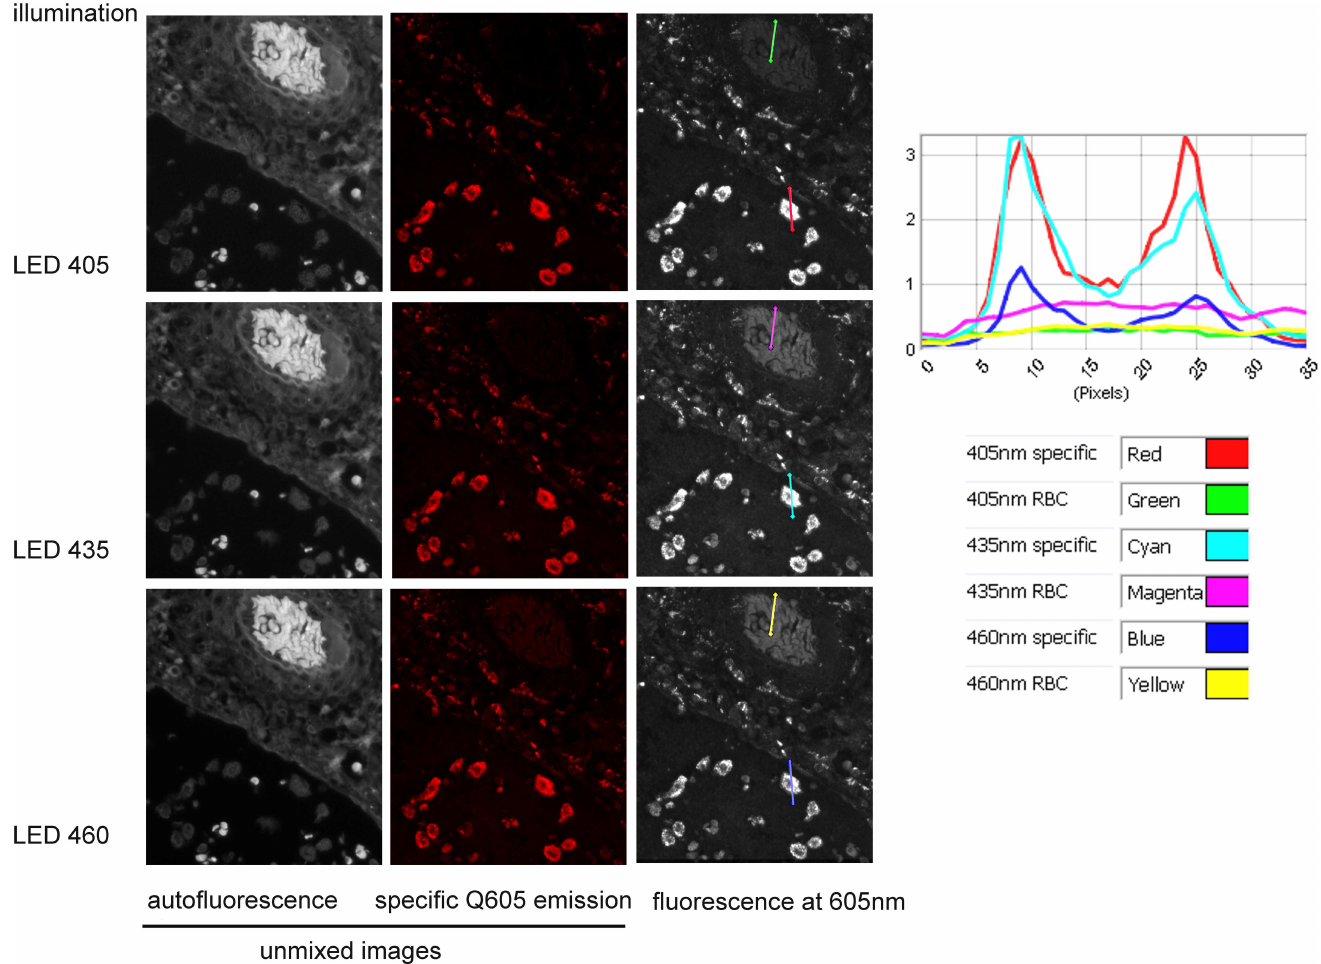
Fig 8. Comparison of specificand autofluorescence levels withLED illuminationat 405, 435 or 460nm. Left & middlepanels:intensityimages unmixed froma cube of imagestaken between500 and 720nm using a tunable filtercamera (NuanceFX),showing the autofluorescence and Qdot 605. Right panel & curves: Imageswere taken at 605 nm (peak of specific fluorescence) using the Nuance tunable camera.The same profilelines drawn on red blood cells (green,magenta& yellow lines) and on a macrophage positively labelled(red,cyan & blue) give the fluorescenceintensityprofileshown on the graph. Note that specific stainingis of similarlevel in picturestaken under405 and 435 nm (red& cyan curves)but autofluorescence is stronger in 435nm (comparemagenta& green curves).